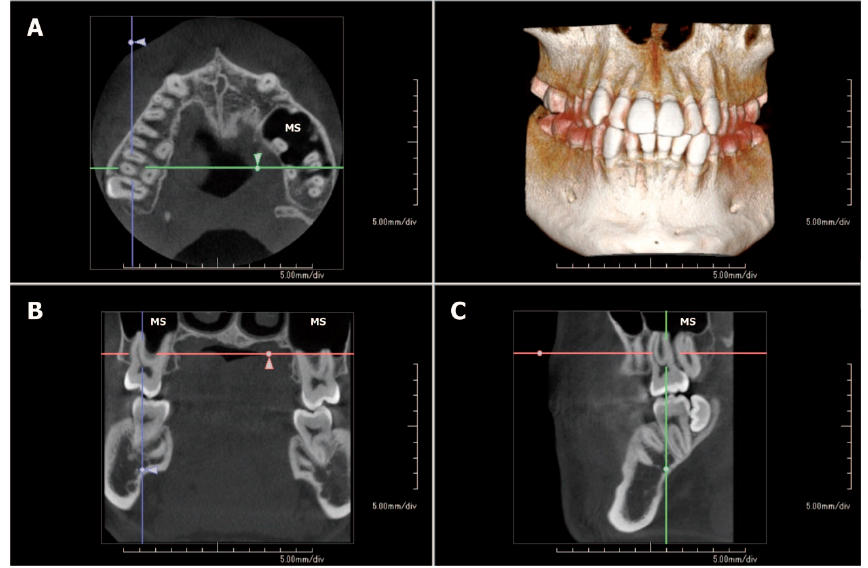
Figure 4. Pretreatment cone-beam computed tomography (CBCT) images of the relationships between the maxillary molars and the maxillary sinus. ( A ) Axial image; ( B ) coronal image; ( C ) sagittal image simultaneously. Abbreviation: MS, maxillary sinus.